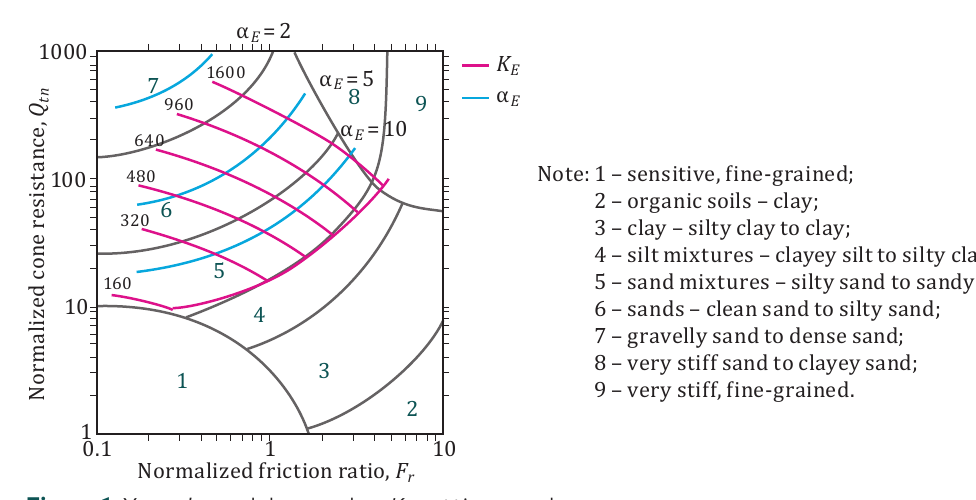
Figure 1. Young’s modulus number K E setting graph